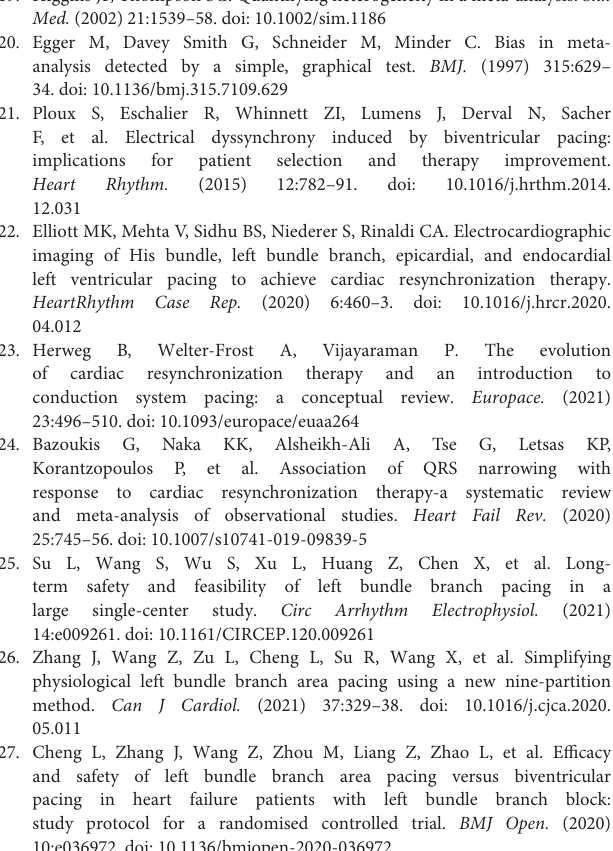
and safety of left bundle branch area pacing versus biventricular pacing in heart failure patients with left bundle branch block: study protocol for a randomised controlled trial. BMJ Open. (2020) 10:e036972. doi: